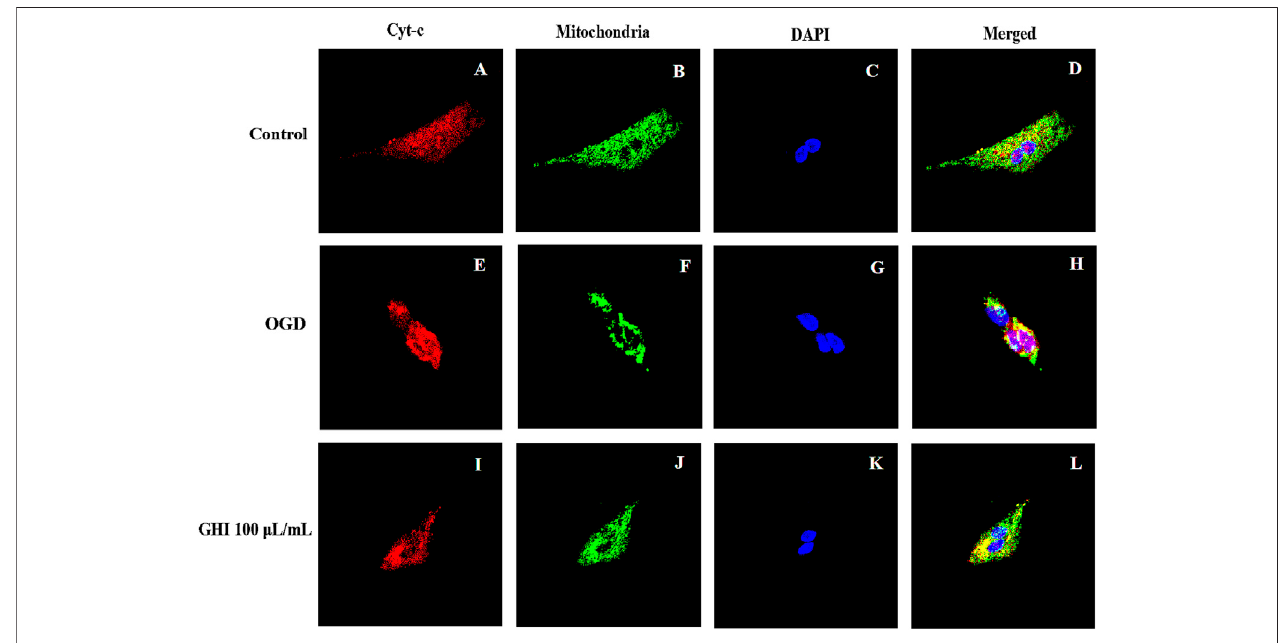
FIGURE 13 | Effects ofGHI onthe releaseofCyt-c frommitochondria after OGD-induced injury.GHI decreases the release ofCyt-c frommitochondria. Cyt-c (A,E,I) , mitochondria (B,F,J) , and DAPI (C,G,K) staining revealed an apparent maintained within the mitochondria under OGD conditions when treated with 100 μ l/ml of GHI (I – L) compared to the without GHI. Cyt-c and mitochondria double-positive cells are shown in panels: (D,H,L) . Red: Cyt-c, blue: DAPI, and green: mitochondria (n (cid:2) 3).